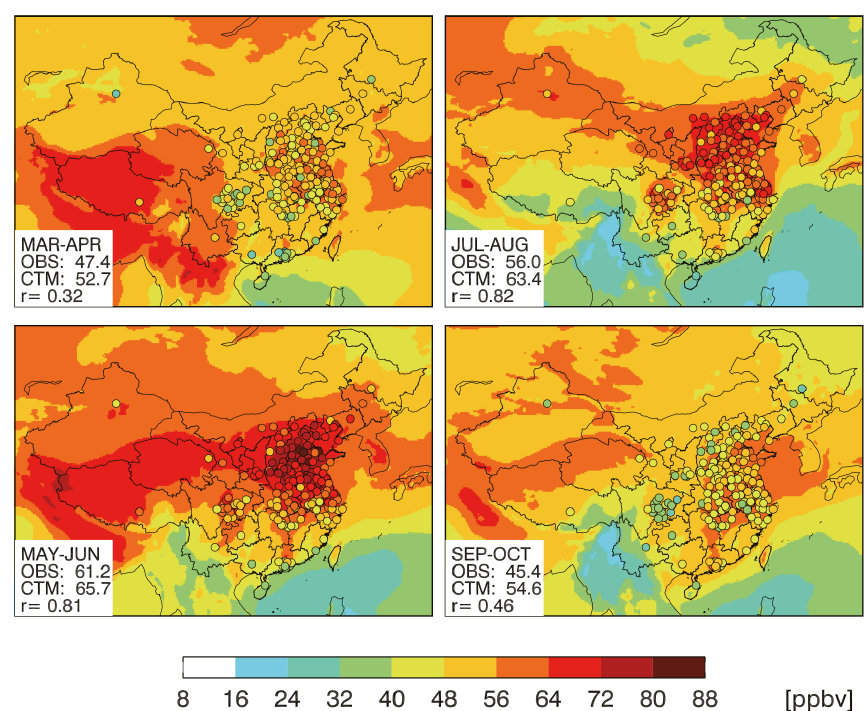
Figure 2. Spatial distribution of observed (circles) and simulated (shaded) bimonthly mean surface daily maximum 8h average (MDA8) ozone concentrations over China averaged for 2016–2017. Observations at the 169 major cities are plotted over the GEOS-Chem model results. Observed (OBS) and simulated (CTM) bimonthly mean values averaged for the 169 cities and their correlation coefficients ( r ) are